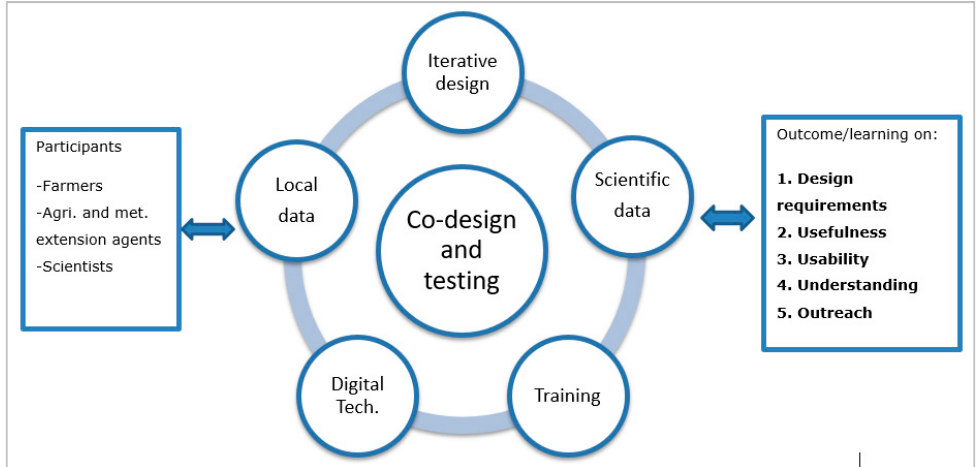
Figure 2. Codesign and testing of agrometeorological information services: methodological flowchart showing the cyclical and iterative process of knowledge development. Local data refer to farmers’ forecasts (based on locally used biophysical indicators) and scientific data refer to model-based forecasts. Digital technology includes information and communications technology (ICT; smartphones, apps, and the internet) used for knowledge exchange and collection of rainfall monitoring data.